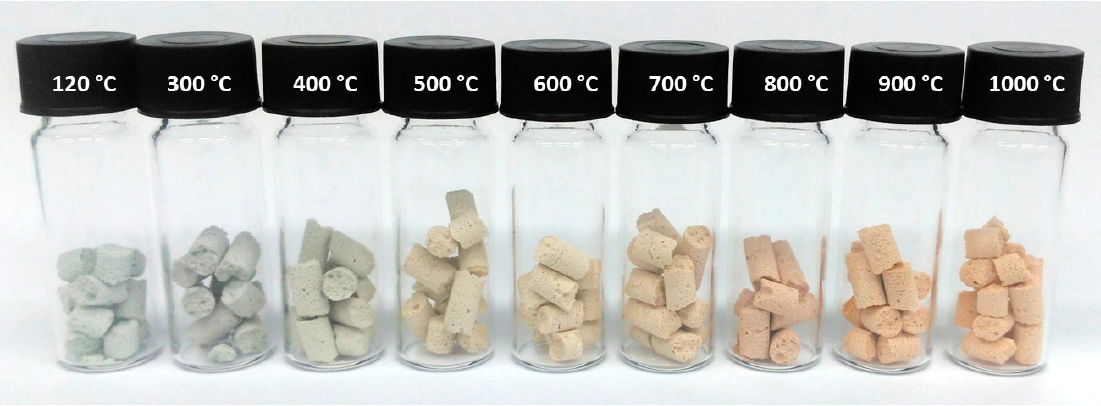
Figure 7. Pictures of the calcined foams.